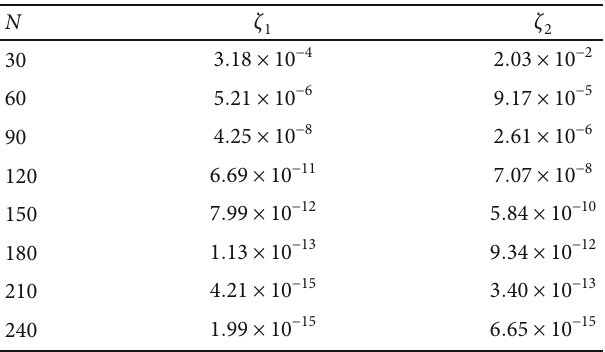
Table 9: The absolute error fractional-order β = 1 and di ff erent quadrature nodes N using the CIM numerical scheme, corresponding to Problem 5.